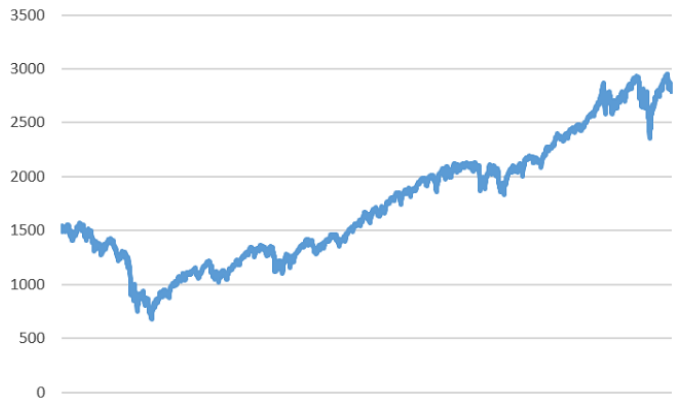
Figure 2. Daily values of the S&P500 index within the period from June 2007 to June Figure 2: Daily values of the S&P500 index within the period from June 2007 to June 2019.